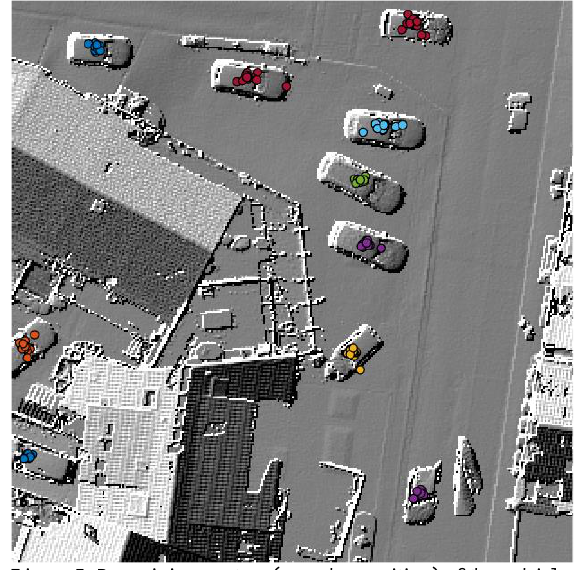
Figure 5. Remaining centres ( x - and y -position) of the vehicles for an exemplary subset of the test area are subdivided with DBSCAN into clusters that are marked with different colours